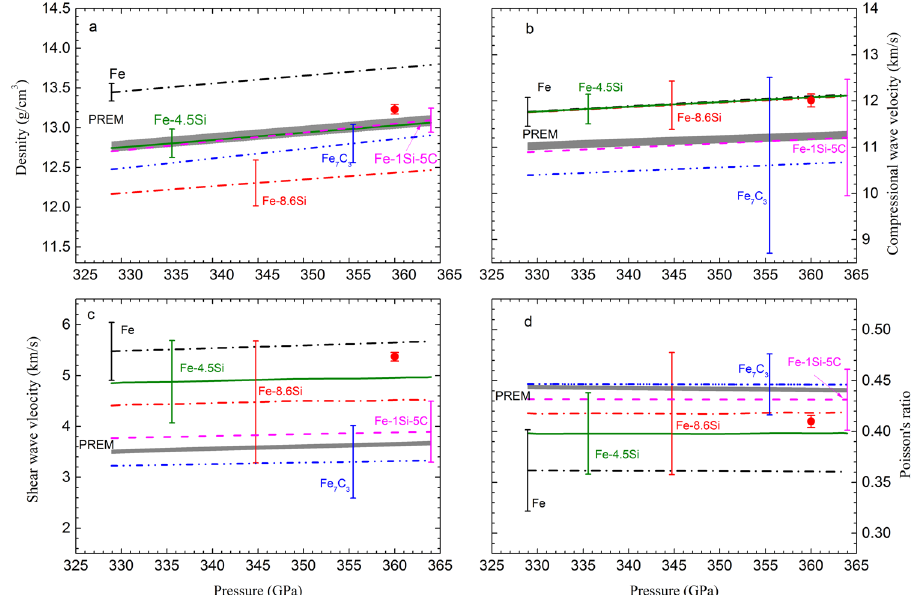
Fig. 6 Comparison of densities, compressional wave velocities, shear wave velocities and Poisson ’ s ratios of various core compositions with PREM values. a The calculated densities of Fe (black dash-dot line), Fe-8.6Si (red dash-dot line), Fe-4.5 wt% Si (olive solid line), Fe 7 C 3 (blue dash-dot-dot line) and Fe-1 wt% Si-5 wt% C mixture (magenta dash line) in the inner core assuming a temperature at inner core boundary of 5440 K, are compared to the PREM density pro fi le. b The same comparison is shown for the compressional wave velocity. c The same comparison is shown for the shear wave velocity. d The same comparison is shown for the Poisson ’ s ratio. The solid circles represent the simulated values for a model composition Fe 60 Si 2 C 2 31 at 360 GPa and 5500 K. The thick gray lines represent the PREM 14 for the inner core, with the line width representing 0.5% uncertainty in density, 0.5% in V P and 1.1% in V s. The PREM uncertainty were derived by comparing different Earth ’ s model 14,15 . Error bars are included for the calculated values. For the best-matched composition, Fe-1 wt% Si-5 wt% C, the error bars show 1.1 % errors in density, 11.4 % errors in V P , 17.1 % errors in V S and 6.8% errors in σ